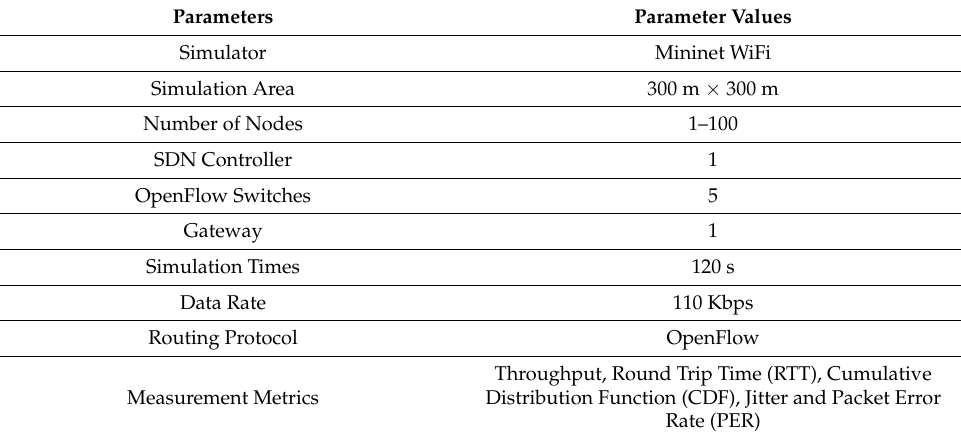
Table 2. Simulated parameters setting for the network